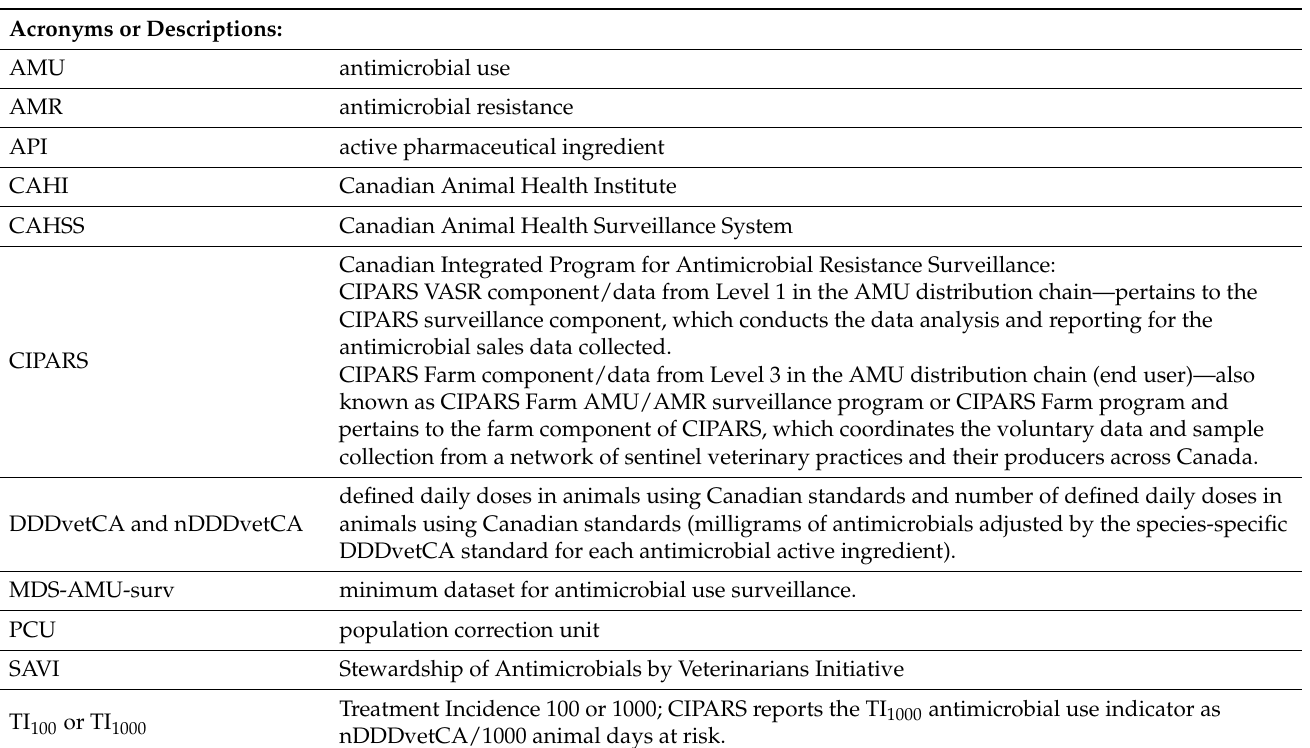
Table A1. Template (current at the time of writing of this manuscript) for reporting of pest control products by aquaculture owners and operators to Fisheries and Oceans Canada. The template to be used can also be accessed here: https://view.officeapps.live.com/op/view.aspx?src=https%3A%2F%